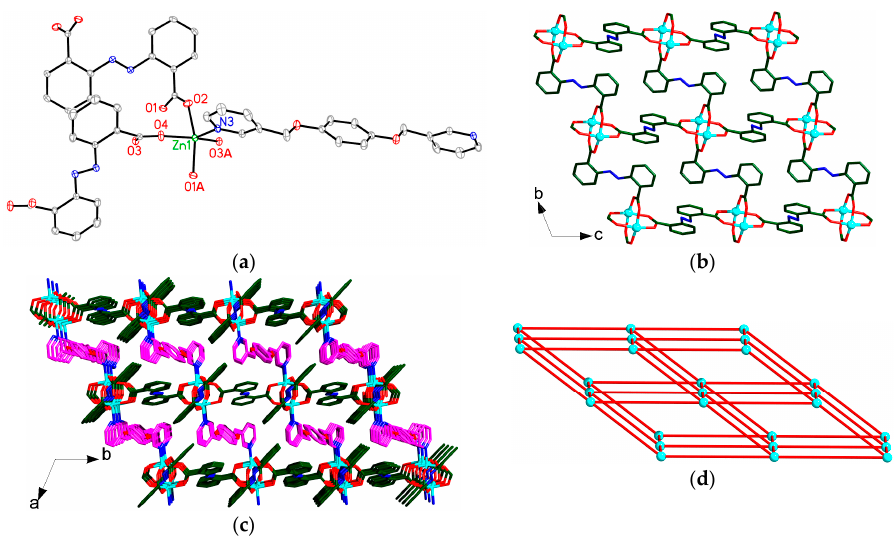
Figure 5. ( a ) View of the coordination environment of Zn center in 4 with labeling schemes. Symmetry